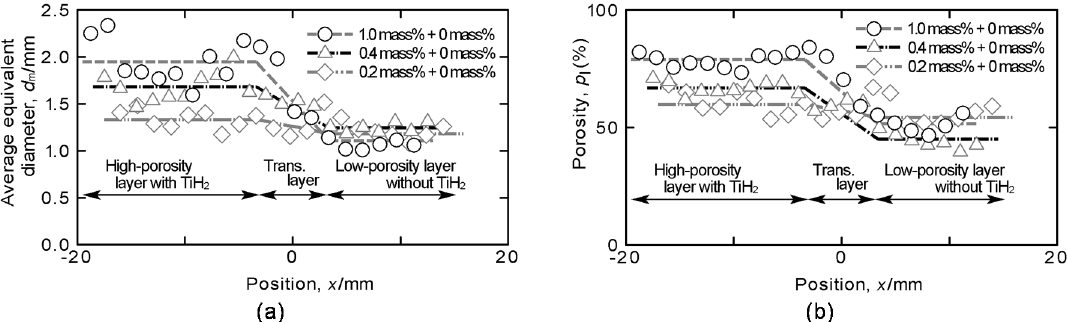
Figure 2. Distributions of ( a ) average equivalent diameter and ( b ) porosity on each cross-section of FG aluminum foams with three combinations of amounts of TiH 2 .